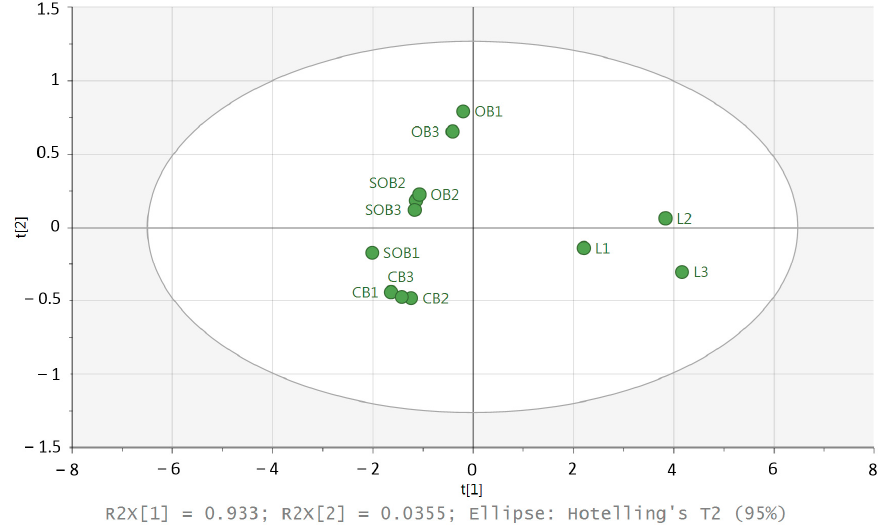
Figure 6. PCA score plot of the G. biloba samples; L1–3 = leaves, OB1–3 = open buds, SOB1–3 = semi- open buds, CB1–3 = closed